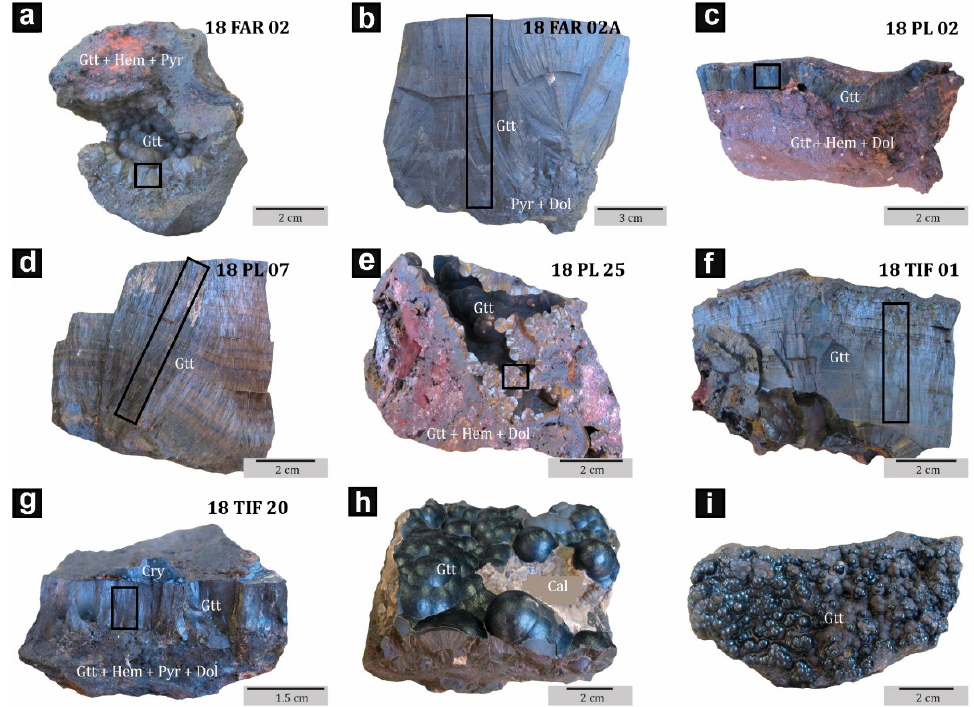
Figure 4. Pictures of botryoidal goethite samples. The distinction between goethite filling thin fractures ( a , c , e , g ) and large goethite filling cavities ( b , d , f , h , i ) is shown. The black frame indicates the area sampled for (U-Th)/He dating and isotopic analyses. Goethite ( h , i ) are exposition specimens for which no (U-Th)/He dating or isotopic analyses were carried out. Gtt = goethite; Hem = hematite; Cry = cryptomelane; Cal = calcite.